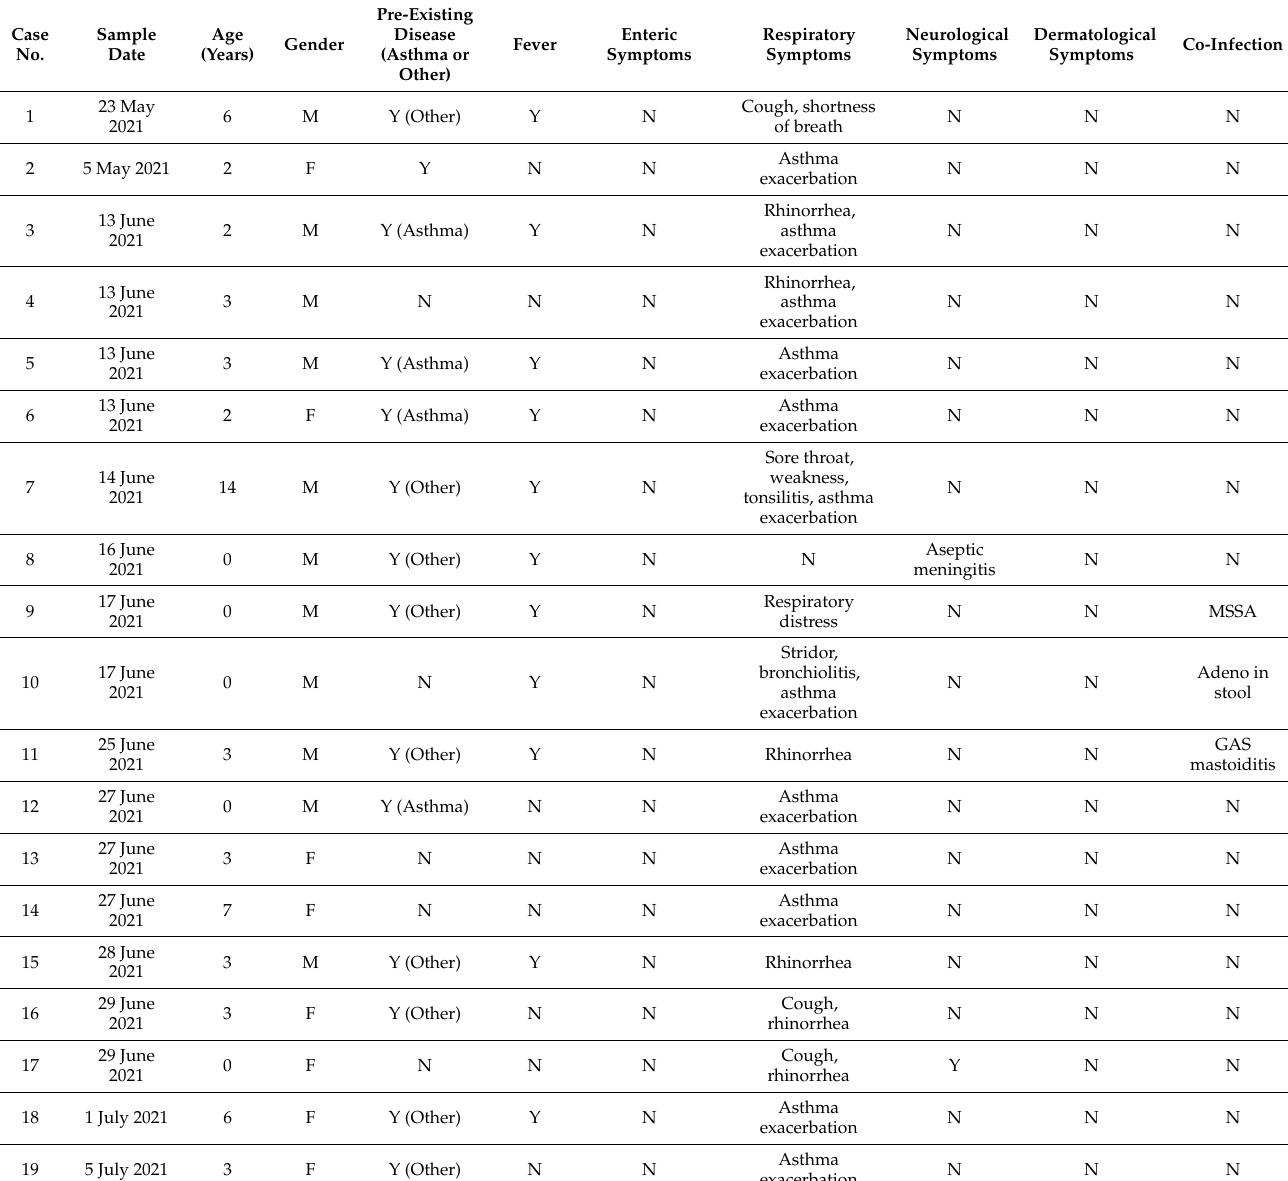
Table 1. Details of the EVD68-positive clinical cases detected in this study. M—male, F—female, Y—yes,